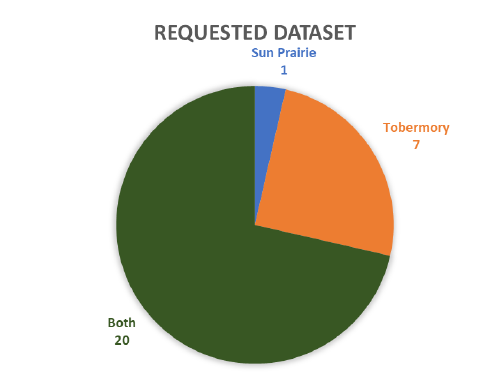
Figure 3 . Requested Data